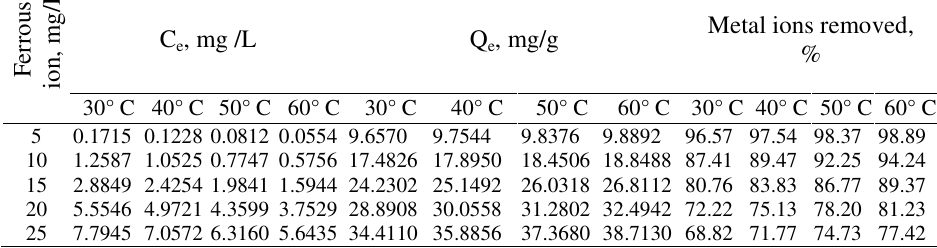
Table 2. Equilibrium Parameters for the adsorption metal ion onto ZDC